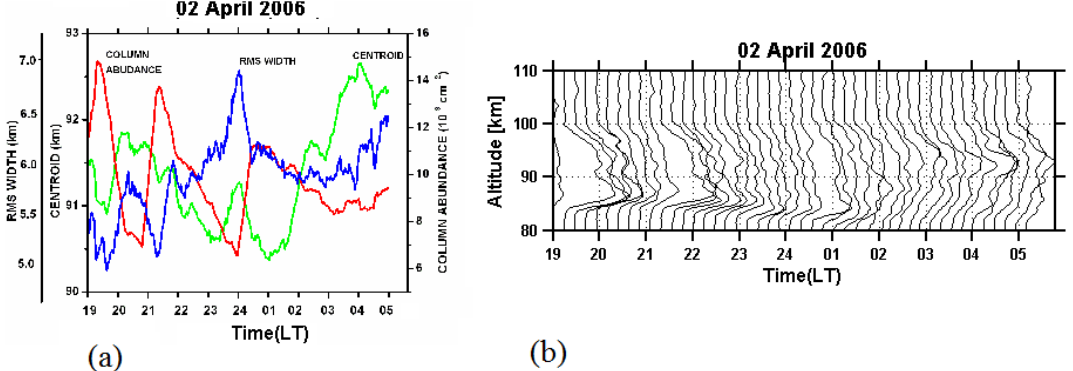
Fig. 5. Temporal variations of the sodium layer column abundance (red line), centroid height (green line) and RMS width (blue line) measured on the night 2/3 April 2006 are shown in (a) . Height profiles of sodium density are plotted in panel (b) , where the profiles are plotted on a linear scale at 15-min